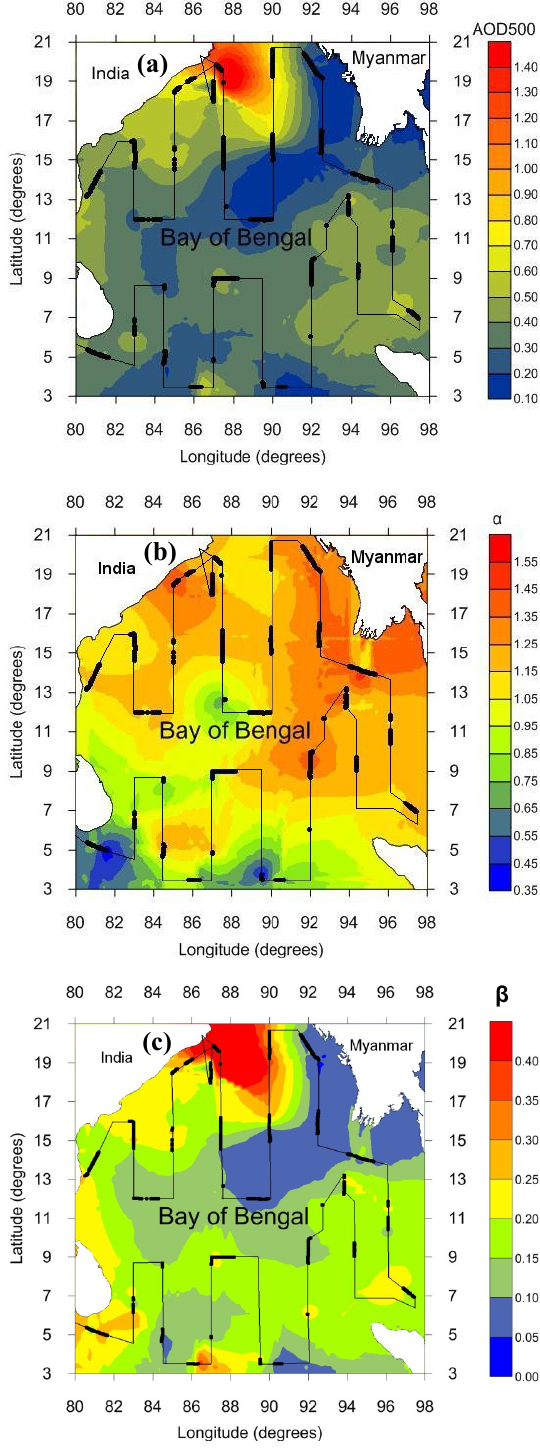
Fig. 4. Spatial distribution of (a) AOD 500 , (b) Angstrom wave- length exponent ( α 380 − 870 ) and turbidity coefficient ( β) obtained by MICROTOPS-II over BoB during W-ICARB. The line shows the ship’s movement and the dark points the sun photometer mea-